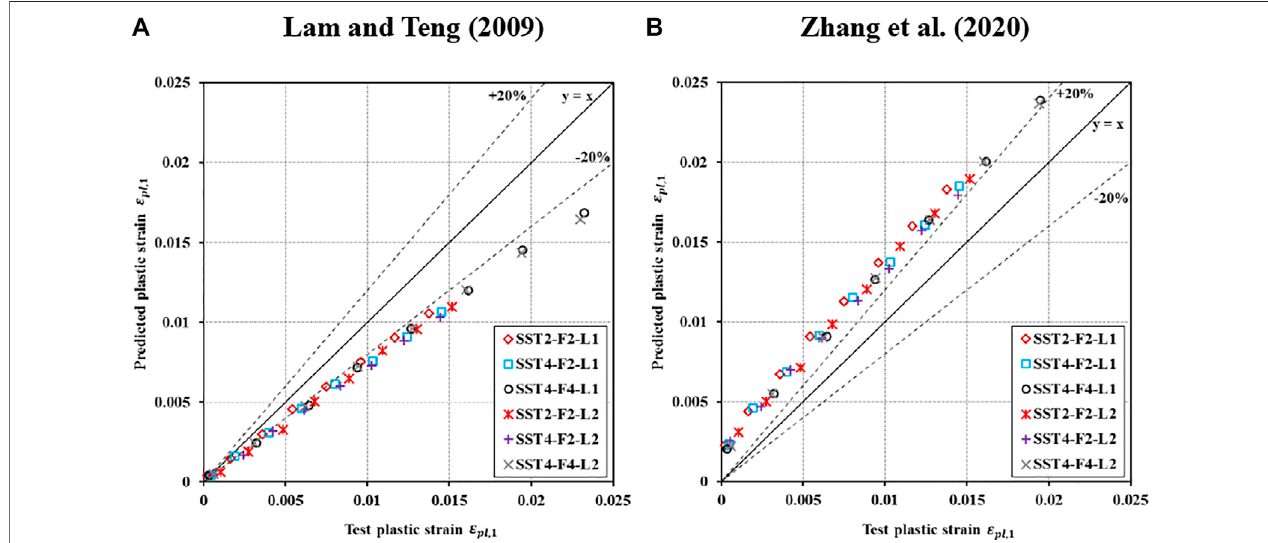
FIGURE 9 | Assessment of the model predictions for ε pl , 1 . (A) Lam and Teng (2009) (Lam and Teng, 2009). (B) Zhang et al. (2020) (Zhang et al., 2020b).